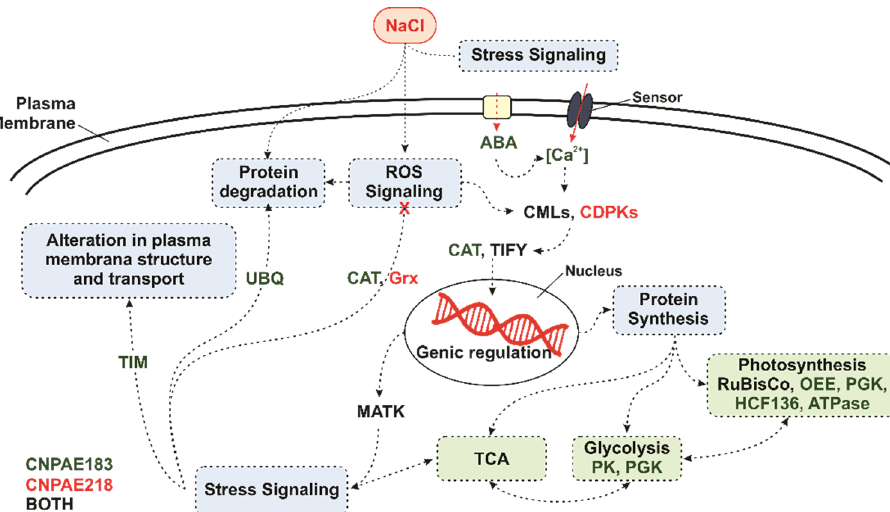
Figure 5. Model proposed for the gene modulation pathway in response to NaCl in two different genotypes of Jatropha curcas subjected to 48 h of 750 mM of NaCl. ABA, abscisic acid. CMLs, calcium- binding proteins. CDPKs, calcium-dependent protein kinase. MYB, MYB Transcription factor family. TIFY, TIFY transcription factor family. RuBisCO, ribulose 1,5-bisphosphatase carboxylase- oxygenase. OEE, oxygen-evolving protein. PGK, phosphoglycerate kinase. HCF136, photosystem II assembly/stability factor. ATPase, ATP synthase. PK, pyruvate kinase. MATK, maturase K. TIM, translocase of the mitochondrial inner membrane. UBQ, ubiquitin transferase. CAT, catalase. Grx, glutaredoxin. Modified from the work of Corte-Real, Oliveira [75].